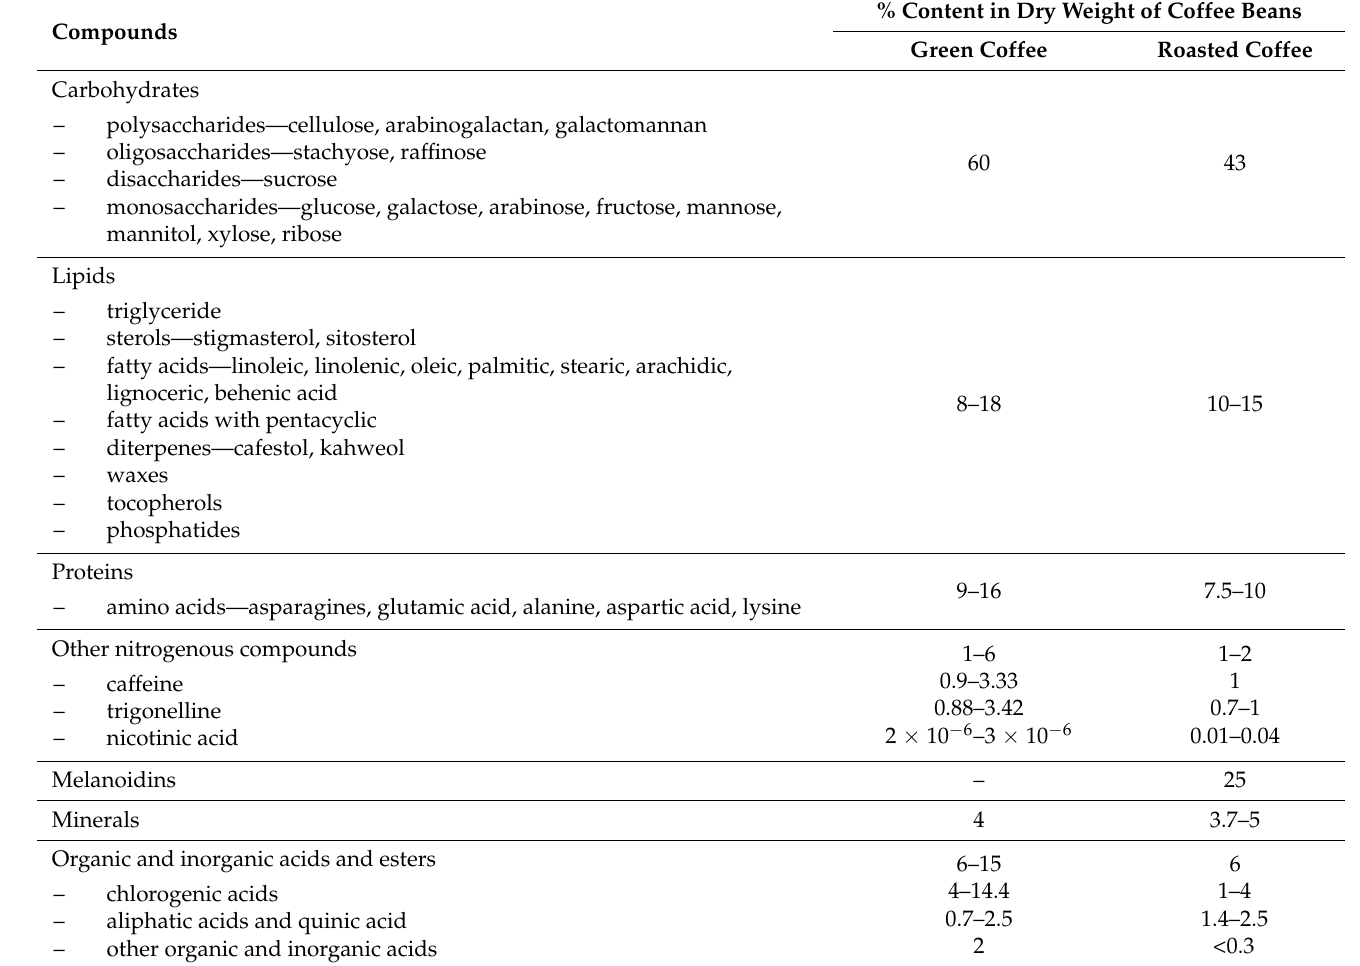
Table 1. The chemical composition of green and roasted coffee beans